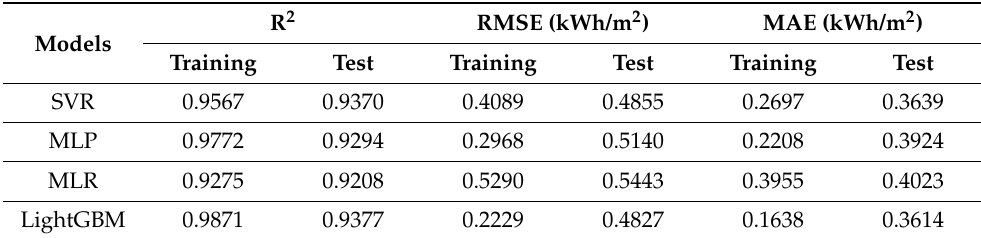
Table 3. Statistical indicators for SVR, MLP, MLR, and LightGBM models.